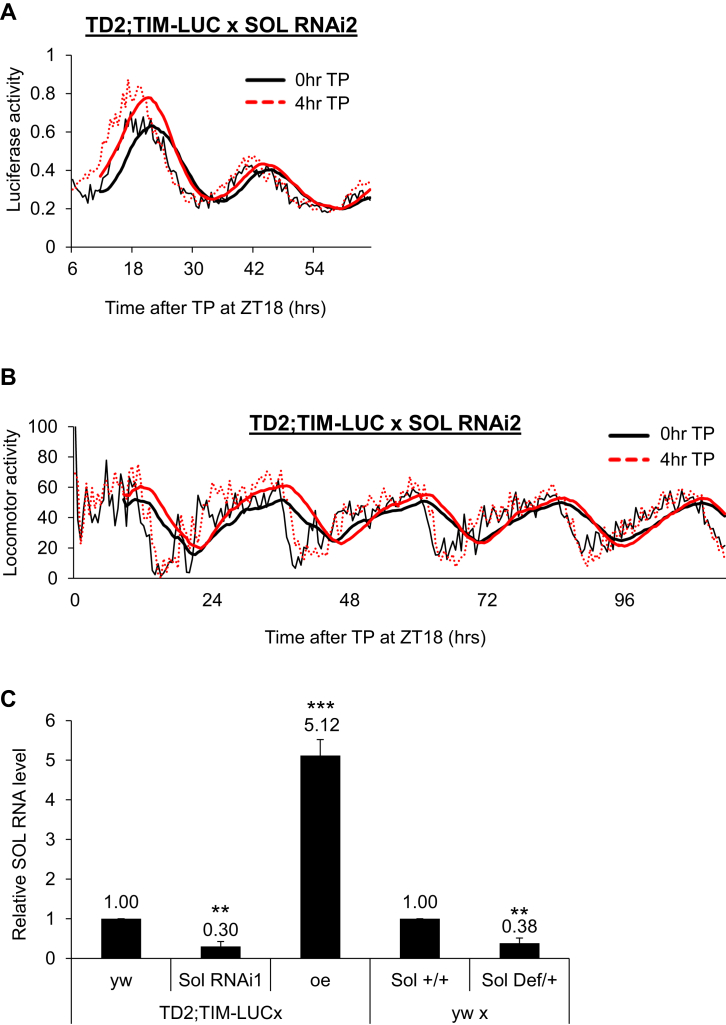
SOL Protease Mediates Temperature-Induced Phase Shifts, Related to Figure 4(A and B) SOL RNAi reduces phase-shifts induced by a 4 hr TP both in the periphery, as measured by luciferase activity (A) and in the brain, measured by locomotor behavior (B). See Figure S2A and S2C for controls from crosses to y w.(C) sol mRNA levels measured by RT-PCR confirm that SOL is downregulated in flies expressing SOL-RNAi1 and flies heterozygous for a deficiency containing sol, and overexpressed with a EP-element located in the 5′ end of the sol gene (oe). Error bars: SEM p < 0.01 from at least three independent experiments is indicated with “∗∗.”